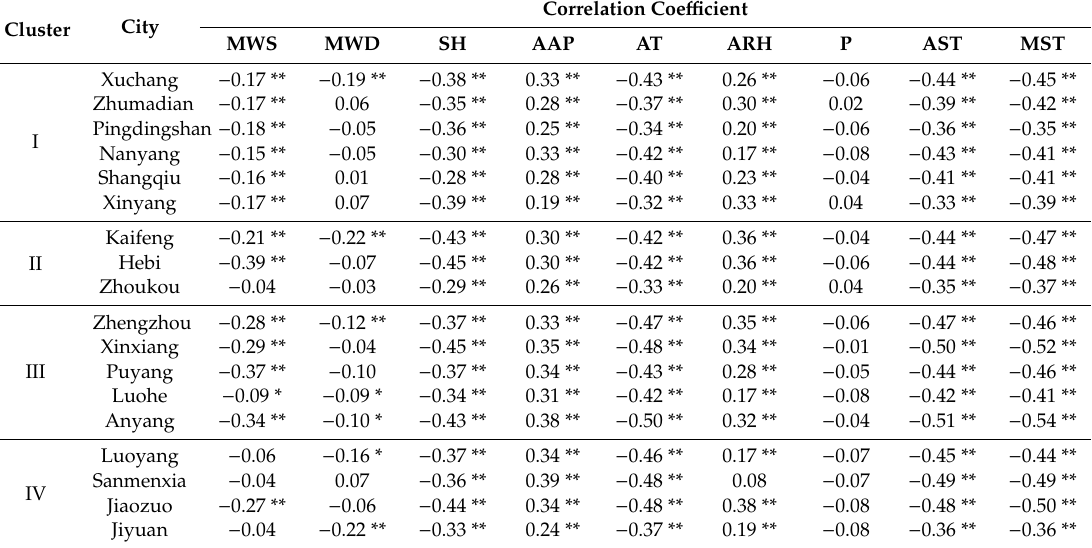
Table 1. Meteorological factors associated with the air quality index on non-attainment days (NAQI) at the city level during 2015–2016. MWS, MWD, SH, AAP, AT, ARH, P, AST and MST denotes the daily maximum instantaneous wind speed and direction, sunshine hours, average atmospheric pressure, average temperature, and average relative humidity, precipitation, average and maximum surface temperature, respectively.